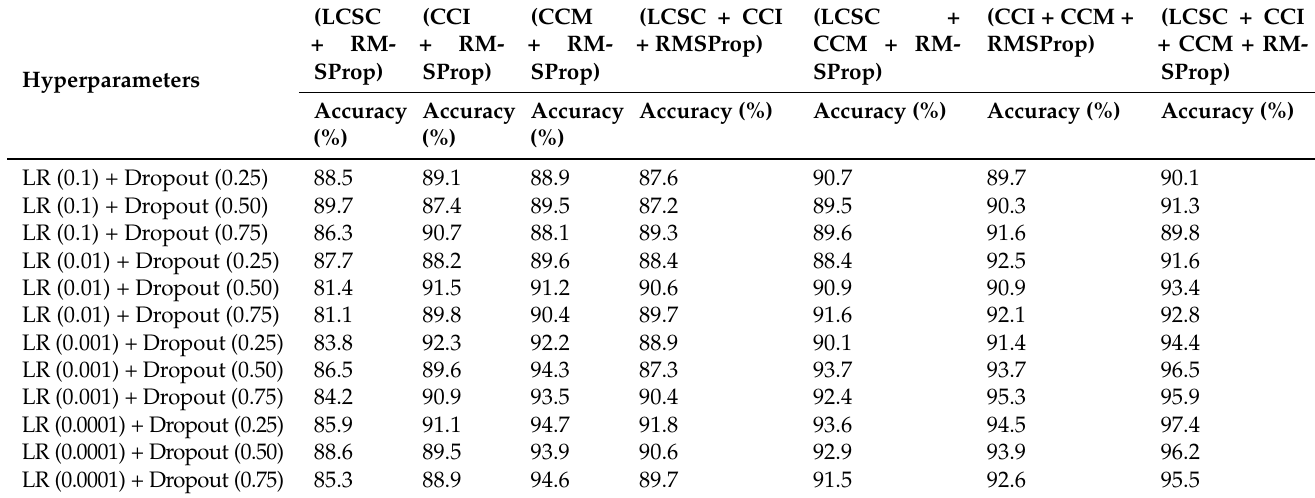
Table 9. Performance evaluation of our proposed model based on different hyperparameter tuning on our dataset with RMSProp optimizer.